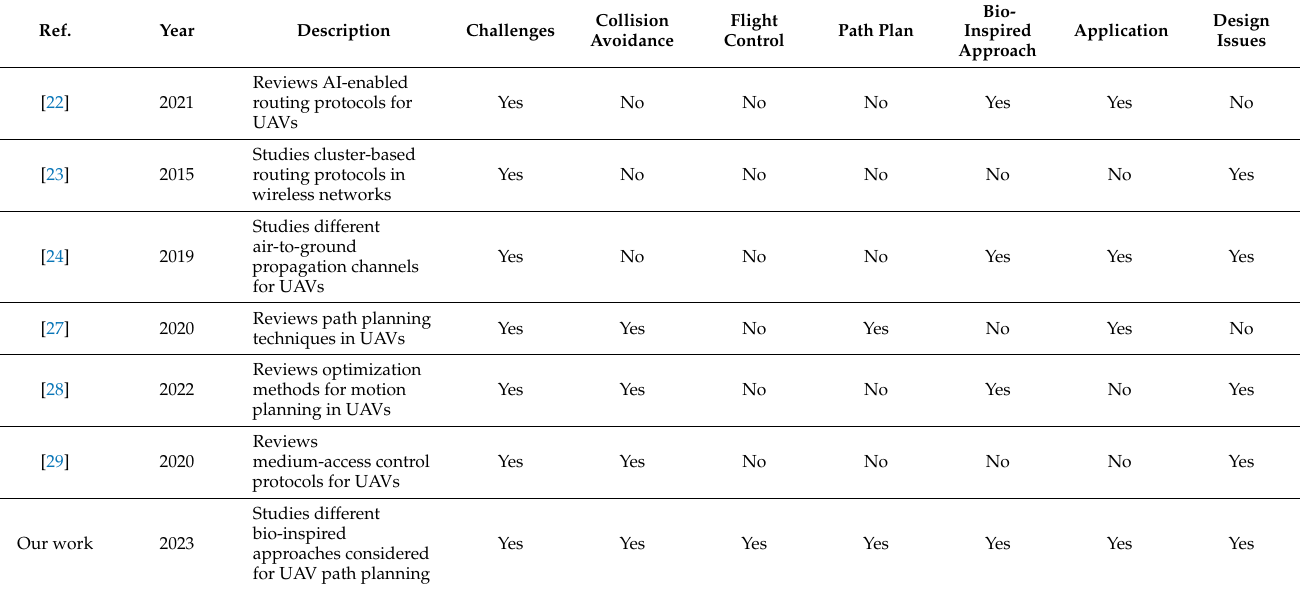
Table 2. Summary of existing